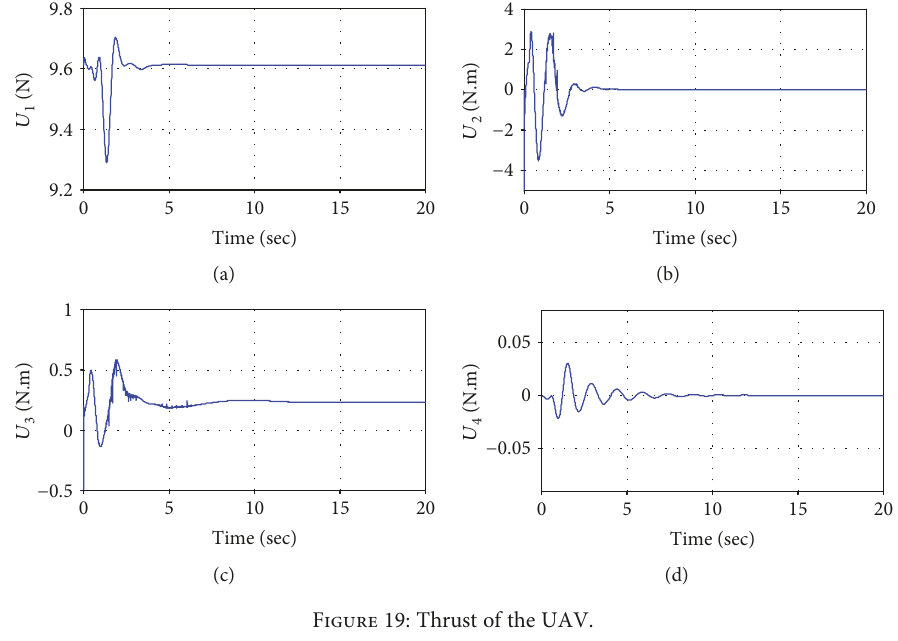
Figure 19: Thrust of the UAV.